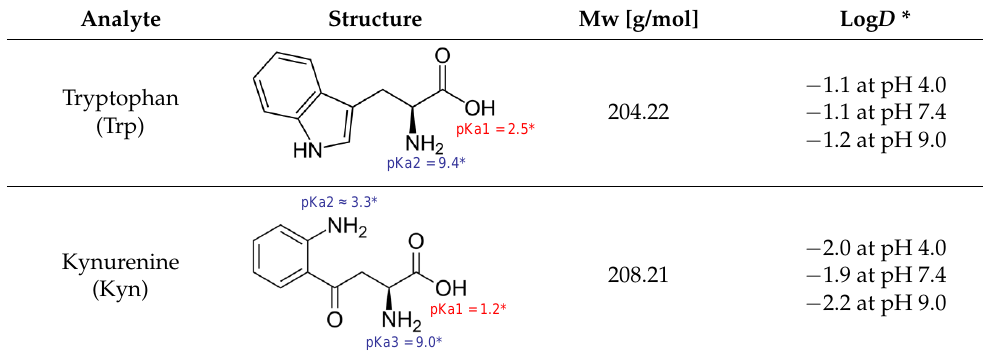
Table 1. Physicochemical properties of two cancer related biomarkers.